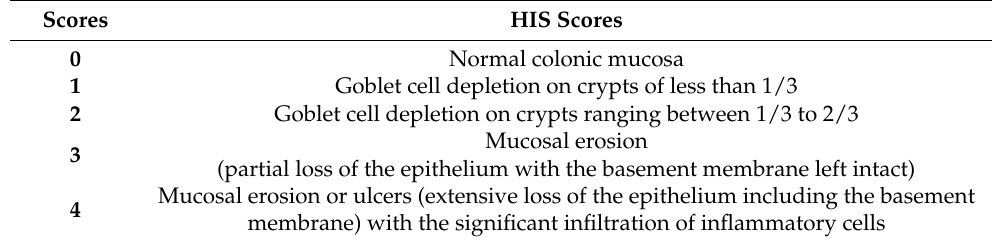
Table 2. Criteria used for histological (HIS)